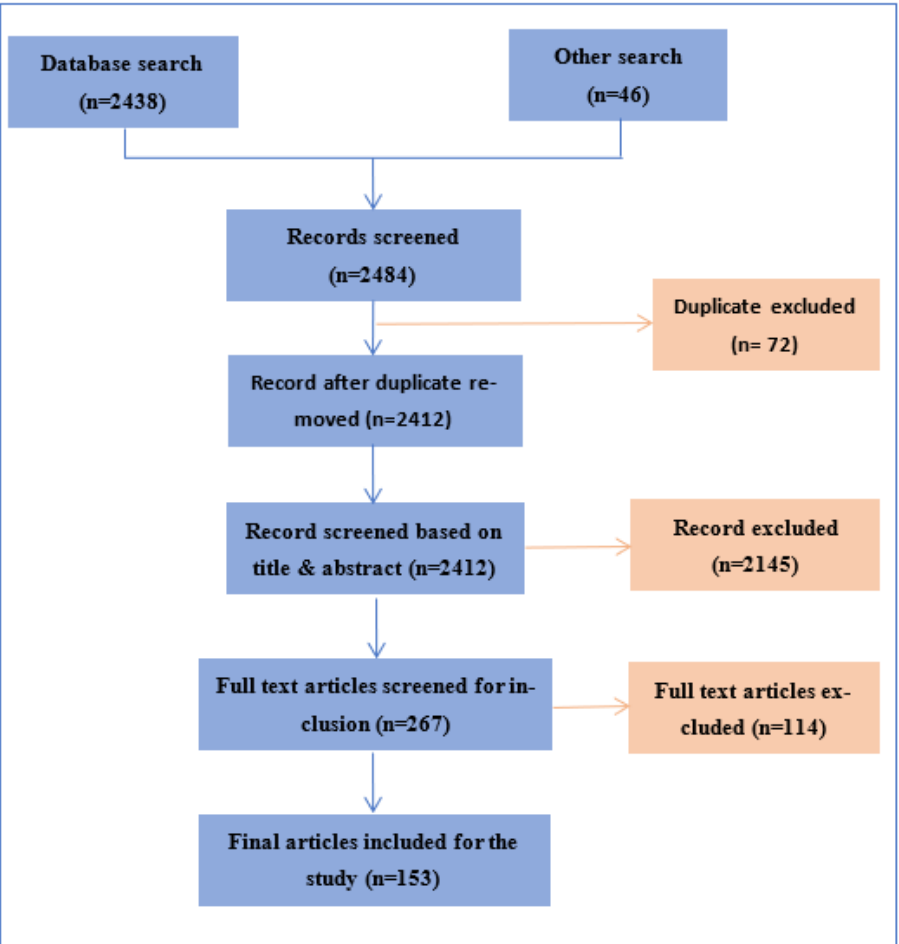
Figure 3. Flow chart for article selection process.